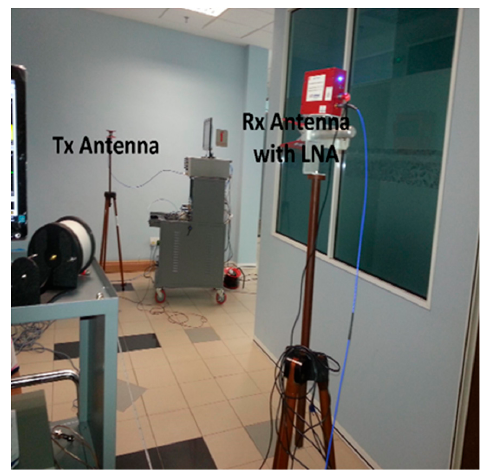
Figure 2. Measurement Environment.